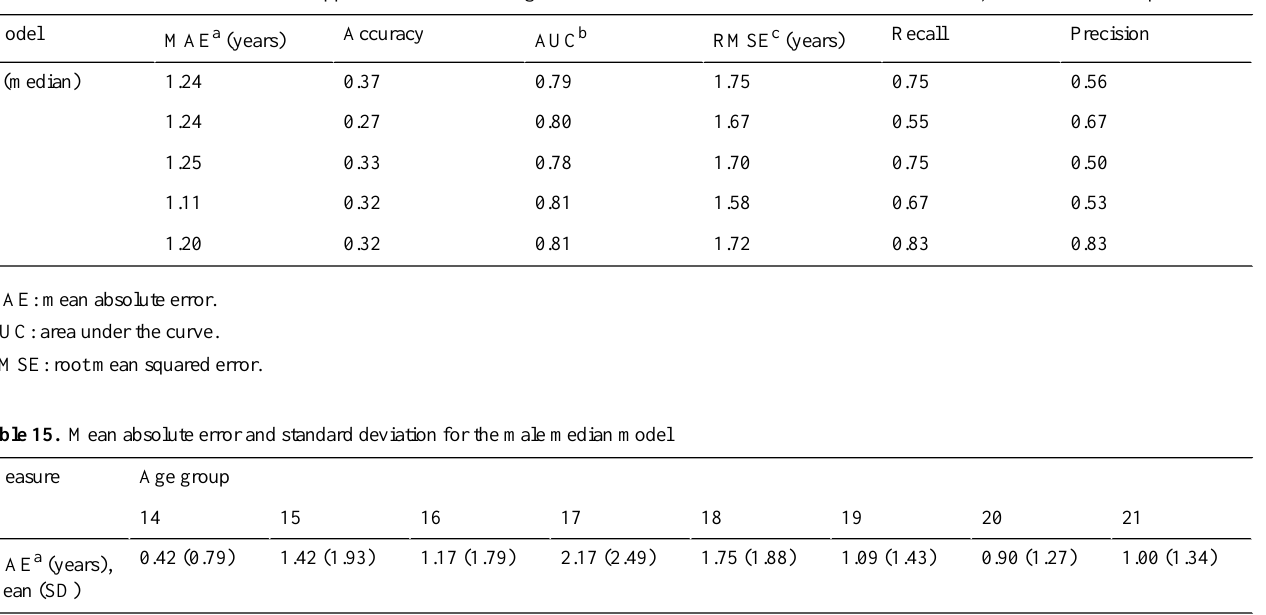
Table 14. Performance results for the support vector machine algorithm on each of the outer cross-validation test sets, for the female sample.